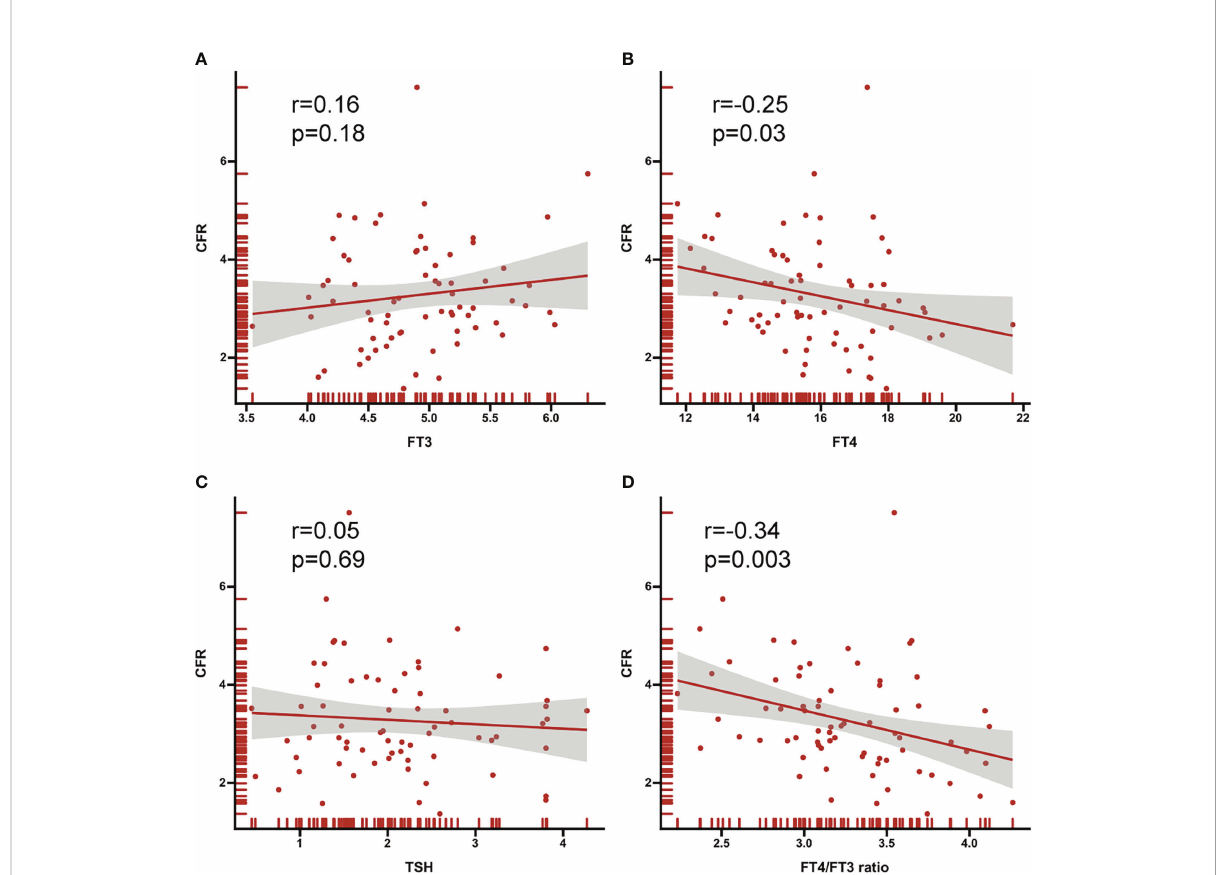
FIGURE 4 Correlation between thyroid hormone (A) FT3 (B) FT4 (C) TSH (D) FT4/FT3 ratio and CFR. Correlation coef fi cients (r) and P values are shown.